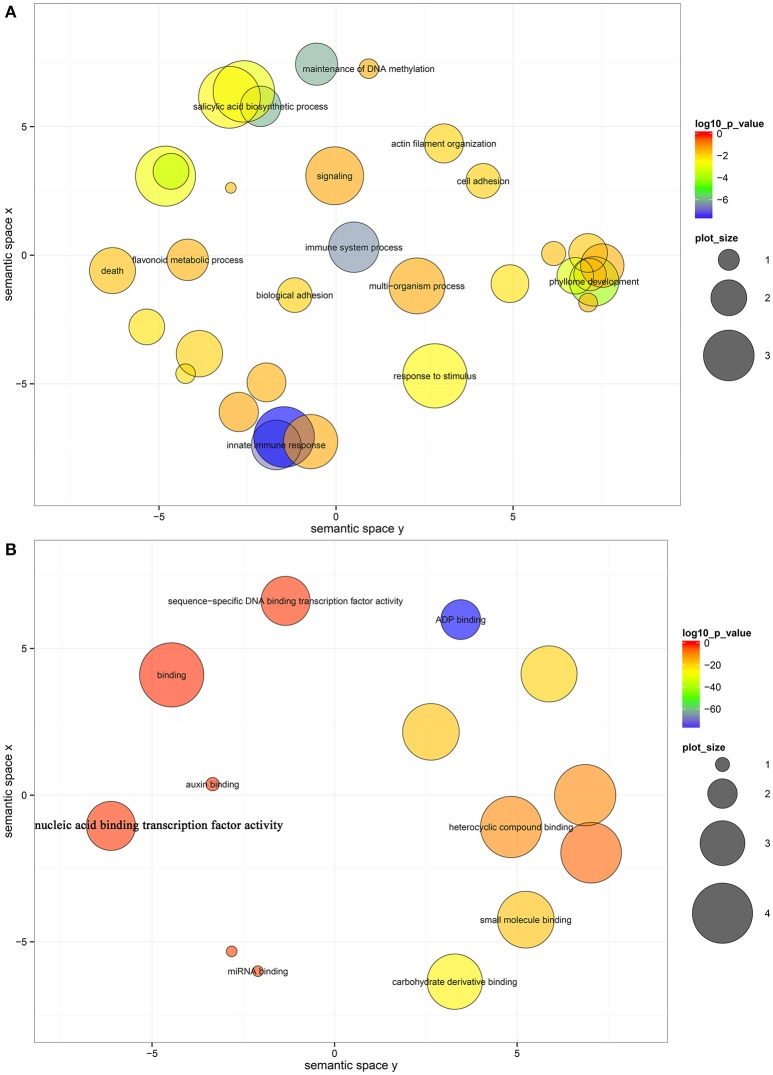
Biological process (A) and molecular function (B) enrichment analysis of the target genes of miRNAs. The bubble color indicates the P-value; the plot size indicates the frequency of the GO term in the underlying GOA database (bubbles of more general terms are larger).